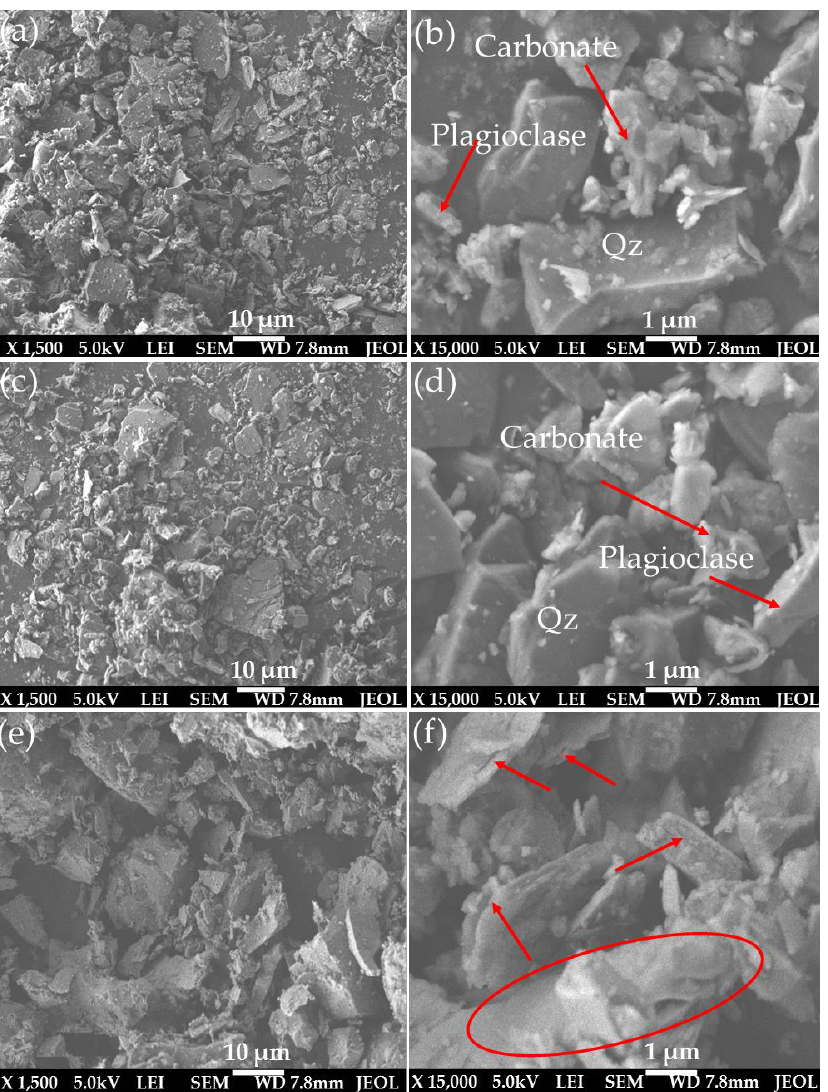
Figure 7. SEM photographs of the studied samples ( a , b : sample at 22 °C; c , d : sample at 600 °C; e , f : sample at 800 °C).